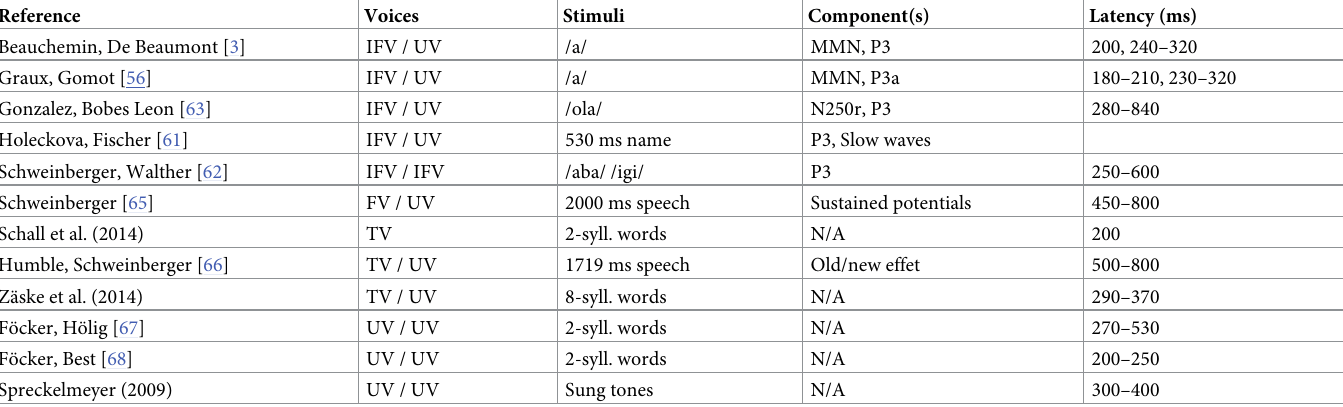
Table 1. Summary of ERP studies of voice processing arranged by type of stimuli and types of voices–intimately familiar voices (IFV), famous/familiar voices (FV), trained-to-familiar voices (TV) or unfamiliar/unknown voices (UV). Only time windows in relation to voice processing are reported in the table.